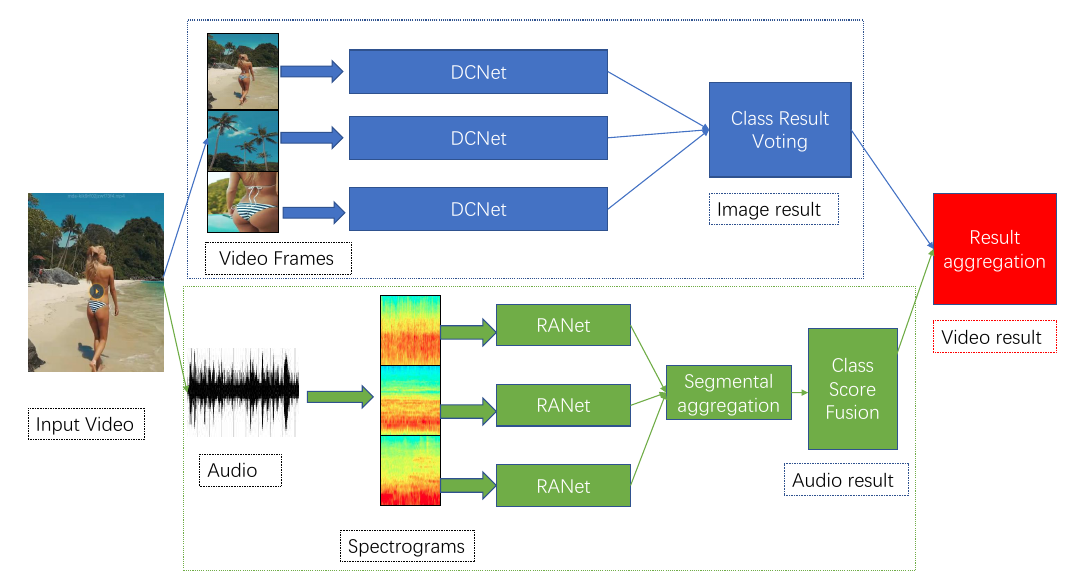
Figure 2. The framework of our proposed method. A video is decomposed into massive image frames and an audio file from scratch. Then, the detection-classification network (DCNet) is used to recognize video frames for porn image recognition, whilst the Resnet-Attention network (RANet) is proposed for porn audio recognition. The final score of the whole video being pornographic is obtained by fusing the image and audio recognition results.